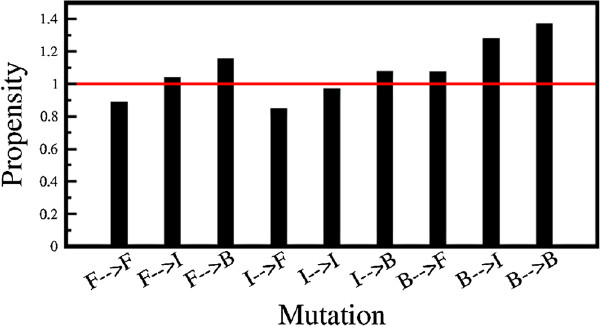
Propensity of different mutations. Propensity of 9 different types of mutations generating a helical conformation from the non-redundant database which map into non-helical conformation in the SCOP database. As depicted in Equation 1, propensity here is the ratio of probability of a given type of mutation leading to ambivalent mutated sequences to the probability of the same type of mutation in the total database of mutated sequences.